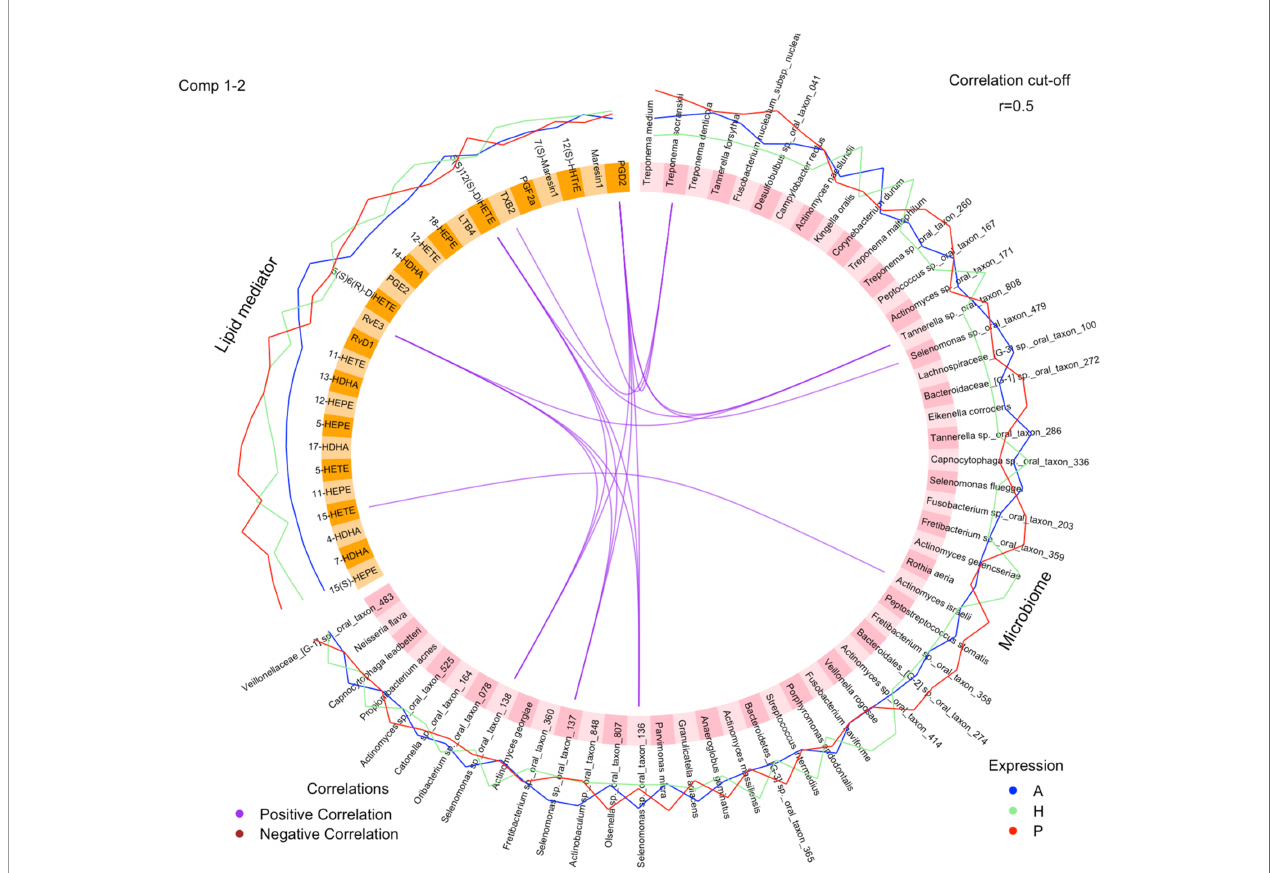
FIGURE 5 | Correlations between individual lipid mediators and bacterial species. The circos plot shows correlations between lipid mediators (yellow) and bacterial species (pink). Three lines outside the circle represent the relative levels of lipid mediators or bacterial species (H (green): healthy; P (red): periodontitis before non- surgical therapy; A (blue): periodontitis after non-surgical therapy). Purple lines inside the circle represent positive correlations between lipid mediators and bacterial species with correlation coef fi cient ≥ 0.5. None of the bacterial species and lipid mediators has a signi fi cant negative correlation coef fi cient ≤ -0.5. The analysis is performed using the DIABLO